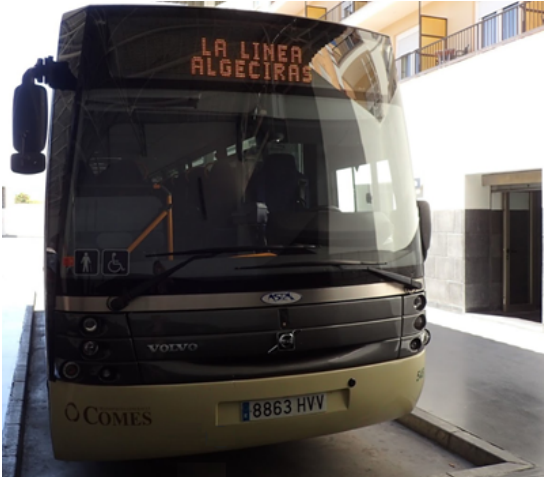
Figure 8. Current bus employed for the analyzed line.